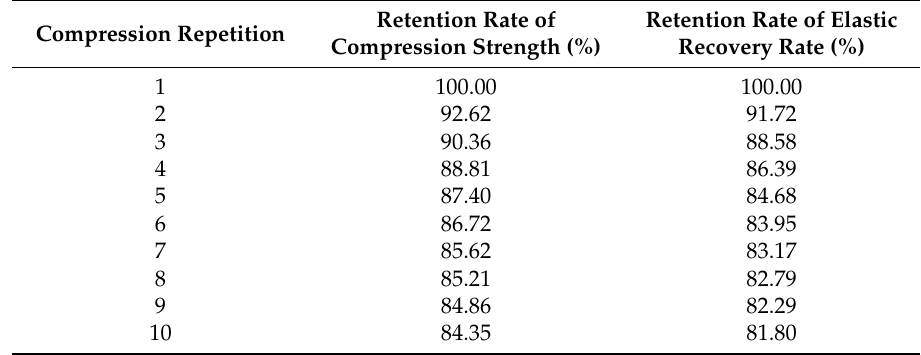
Table 5. Retention rate of compression strength and elastic recovery rate in dry or wet states under di ff erent compression